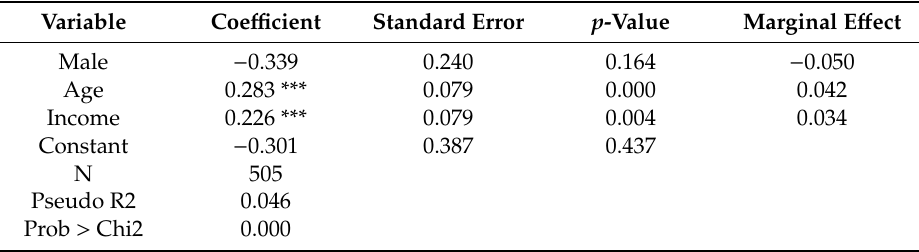
Table 9. Logit model results predicting likelihood to seek veterinary care respondents who own or owned a dog (n =